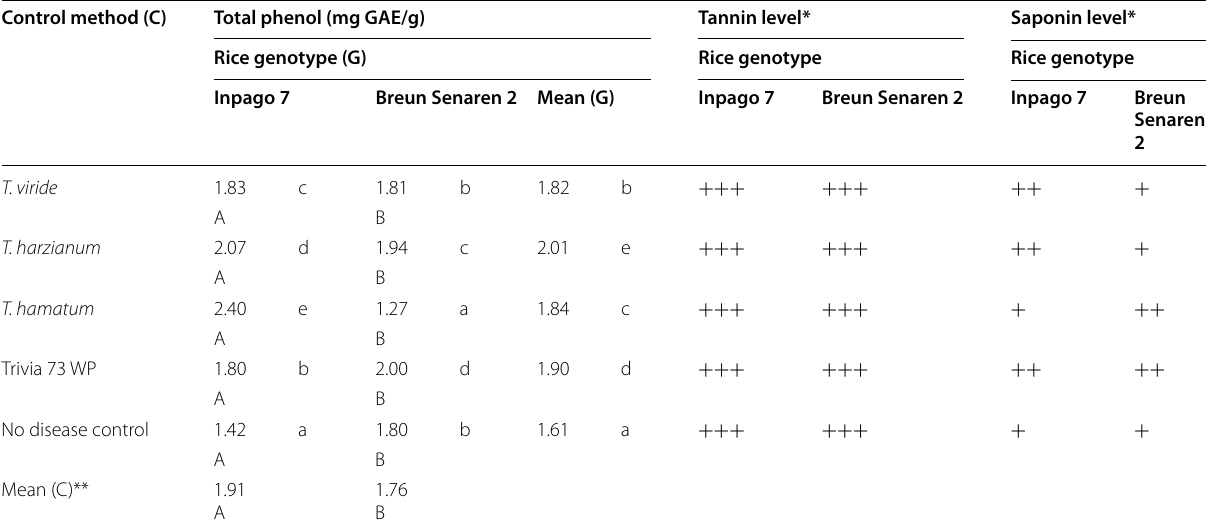
Table 3 Means of leaf phenol, tannin, and saponin levels under combined treatments of disease control method and upland rice genotype